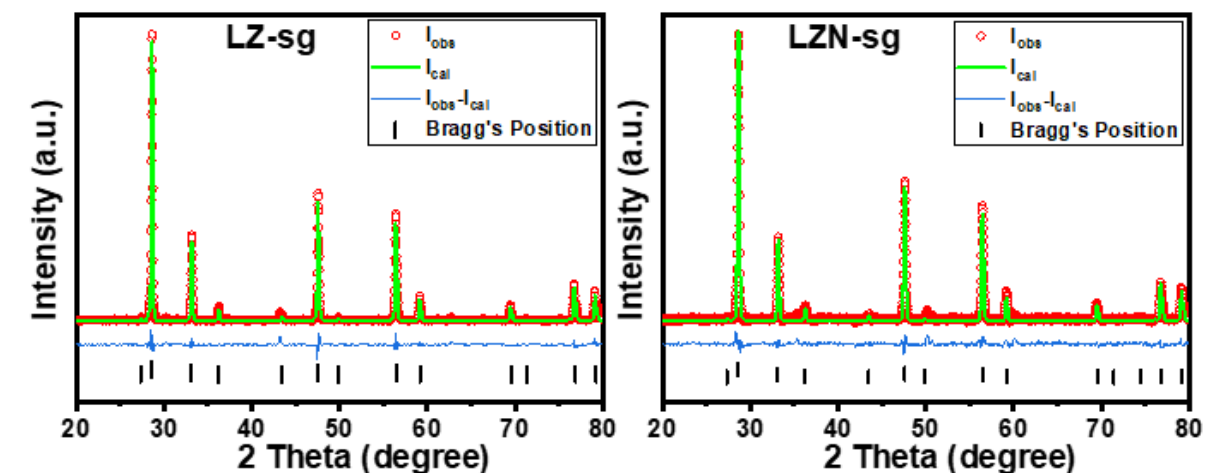
Figure 5. Rietveld-refined XRD patterns for sample LZ-sg and LZN-sg, calcined at 1200 °C. Table 1. Summary of various parameters of La 2 Zr 2-x Ni x O 7 pyrochlores. Sample